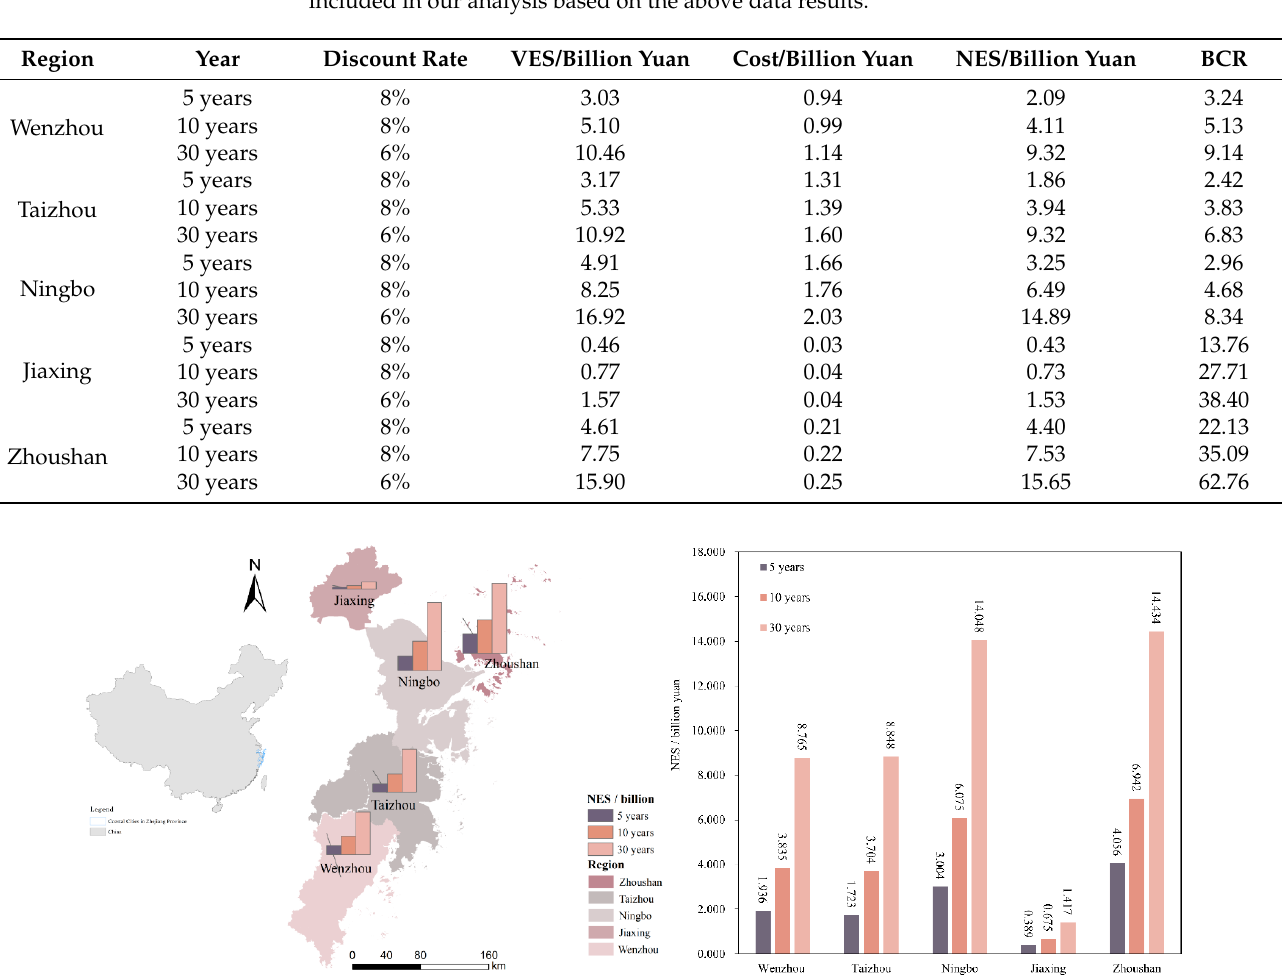
Table 5. The cumulative ecosystem services values (VES), cumulative costs, cumulative net values of ecosystem services (NES) over the return periods, discount rates and BCR for the study areas included in our analysis based on the above data results.